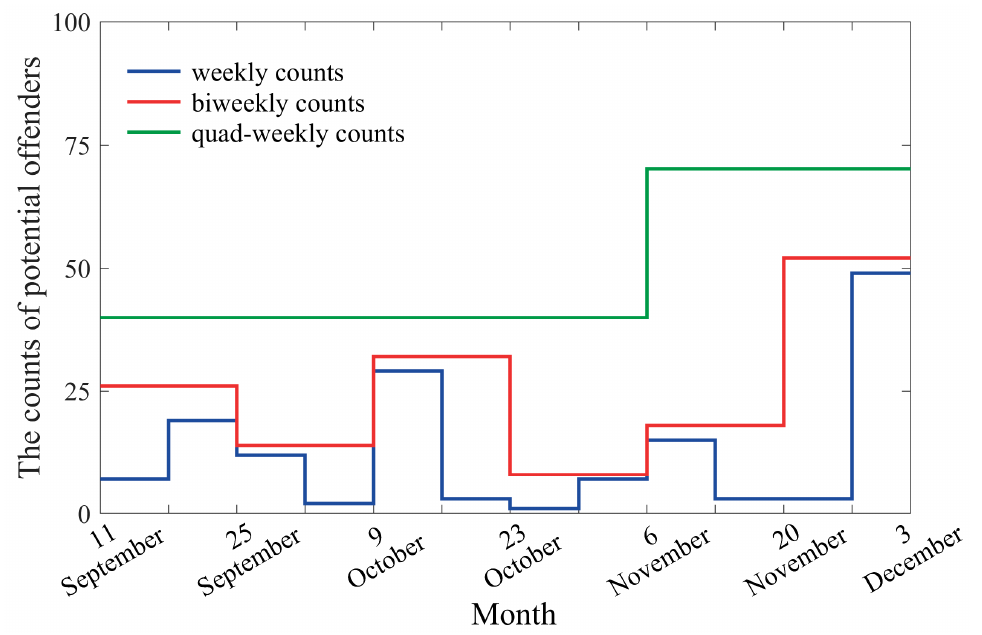
Figure 3. The temporal distribution of the potential offenders in the XT police district on a weekly, biweekly, and quad-weekly basis (11 September 2017 to 3 December 2017).